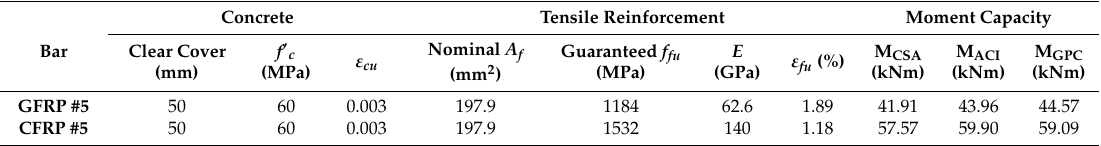
Table 9. Comparison of FRP-reinforced geopolymer concrete with the same reinforcement